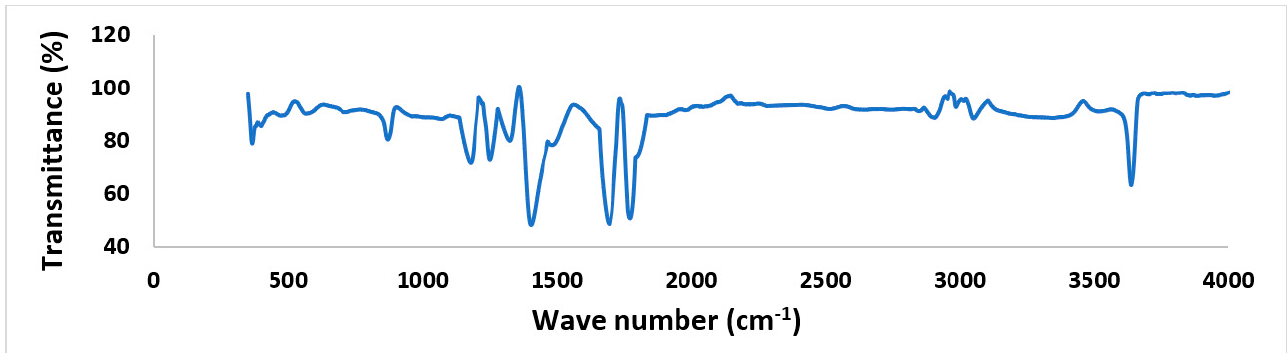
Figure 6. Morphology of the [CaCu(OCH 3 ) 2 ] catalyst—( a ) structure of catalyst, ( b ) identification of catalyst particle sizes.